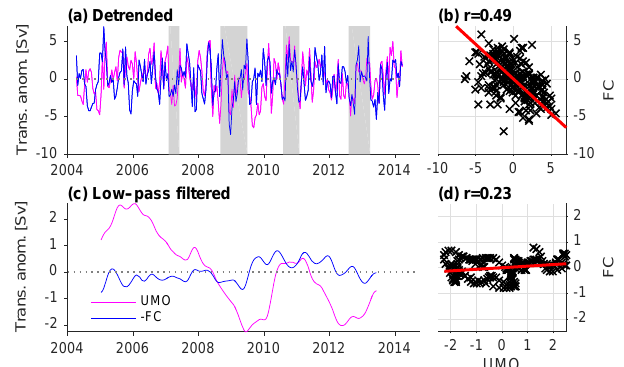
Figure 5. Transport anomaly time series (left column) for the − FC (blue) and UMO (magenta). Zero anomaly is marked with the dashed line. Scatter plots of the same (right column) with correla- tion coefficients ( r ) noted. In (a, b) , the deseasonalized, detrended time series are used. In (c, d) , the time series are deseasonalized and low-pass filtered, but not detrended. The orthogonal regression line is overlaid on the scatter plots. Grey bars highlight periods noted in the